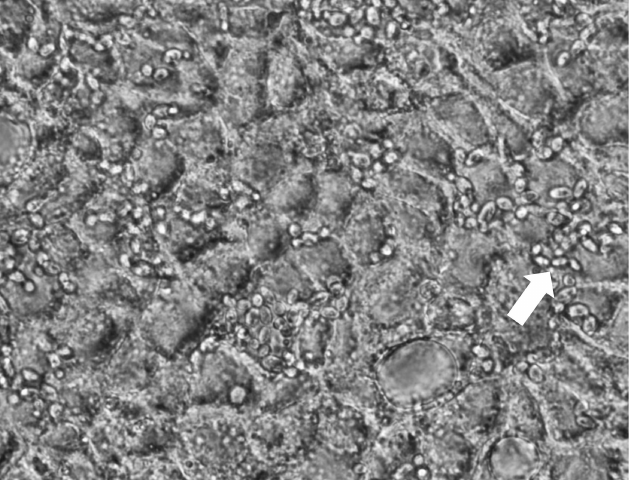
Figure 2. Adhesion of yeast strain 3 to Caco-2/TC7 cells. White arrow points to yeast